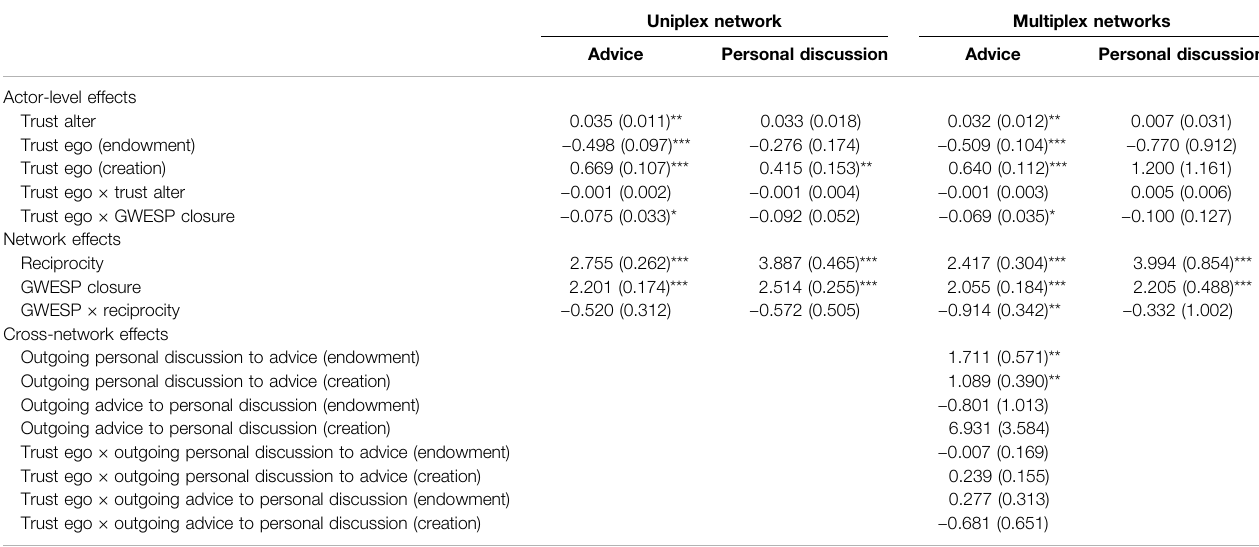
TABLE 2 | Parameter estimates of generalized trust in stochastic actor-oriented